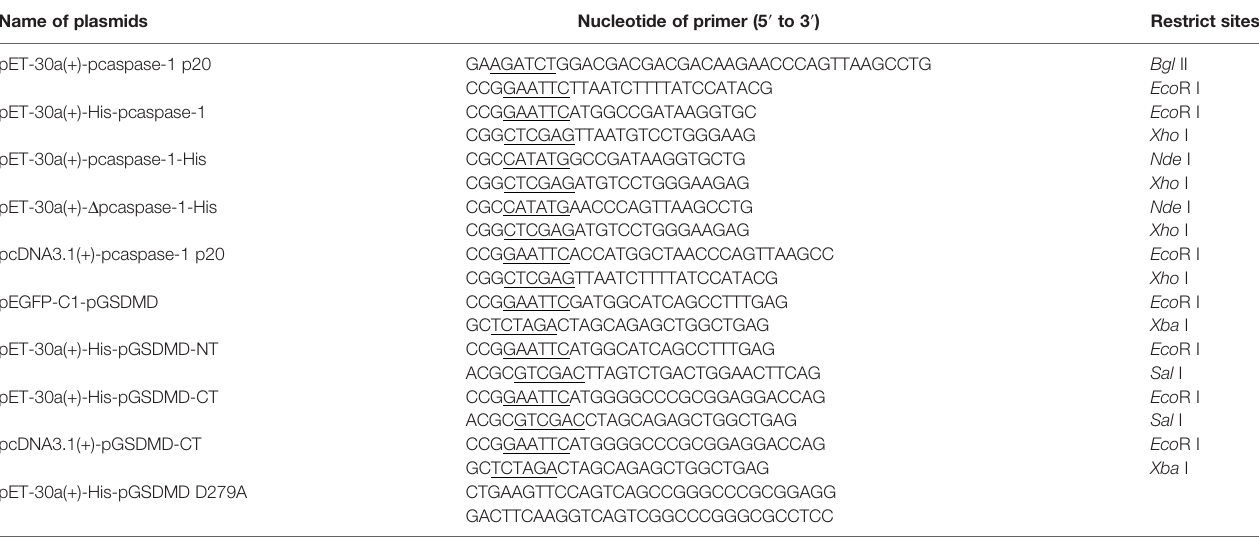
TABLE 1 | Primers used for plasmid